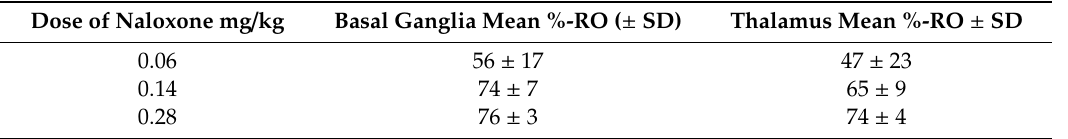
Table 3. Mean % receptor occupancy (RO) by Dose. 1